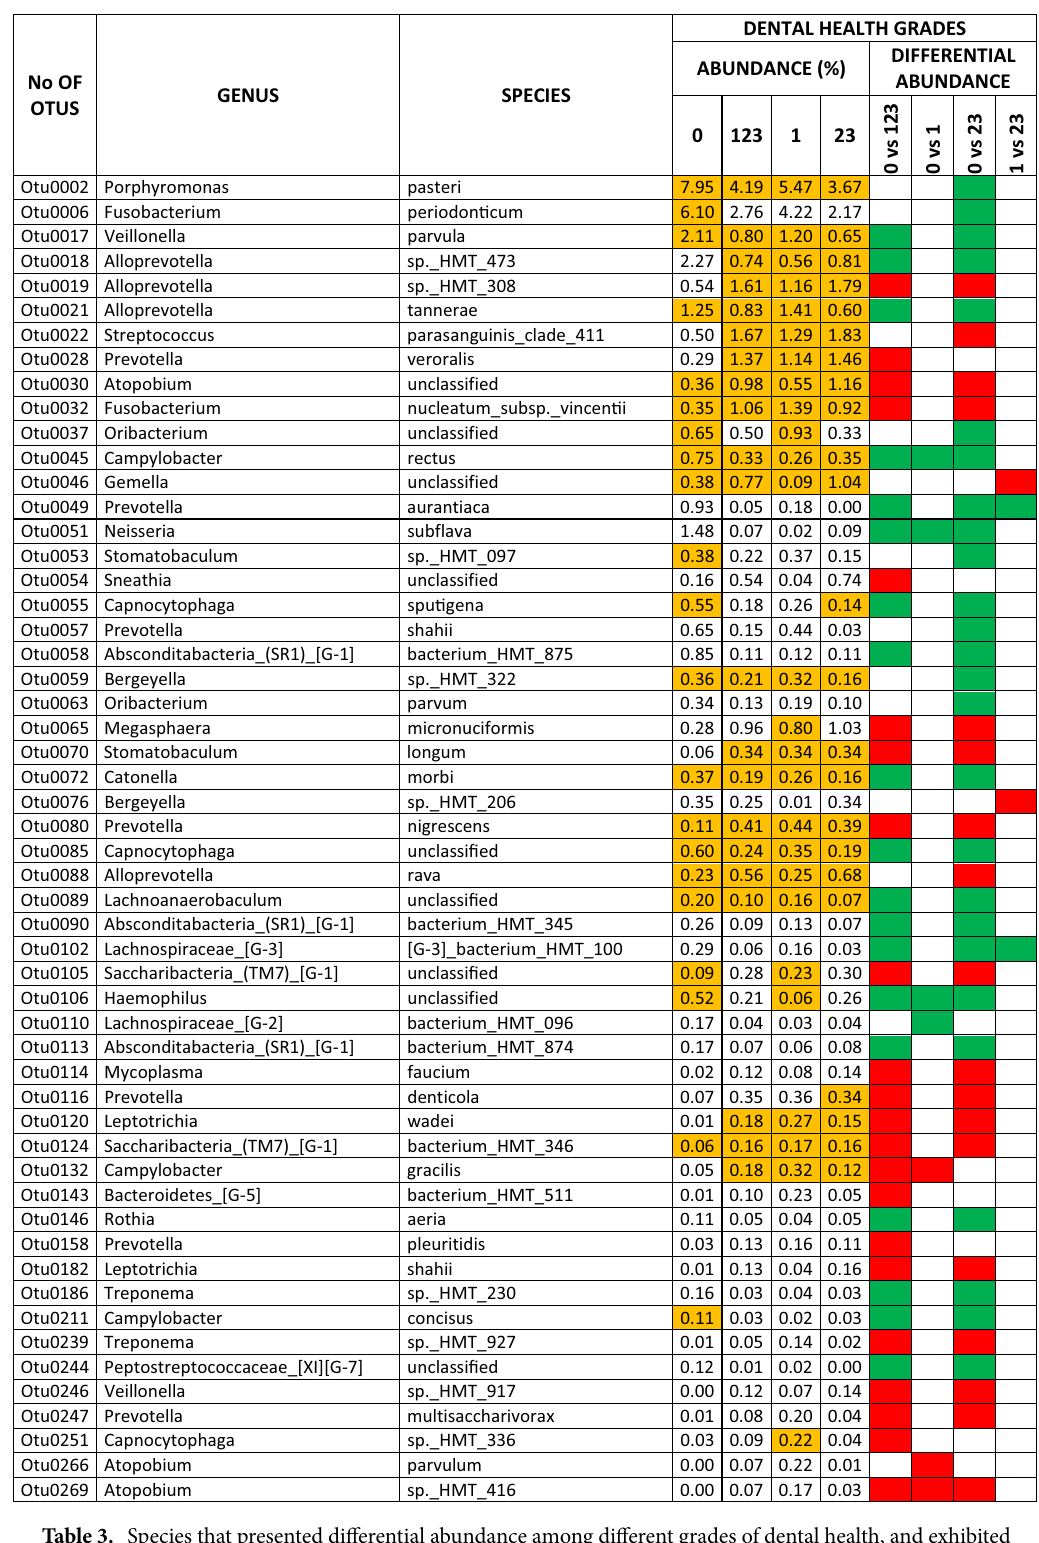
Table 3. Species that presented differential abundance among different grades of dental health, and exhibited an abundance > 0.1% (green square, in favour of health; red square, in favour of pathology). The species that belonged to the core are colored